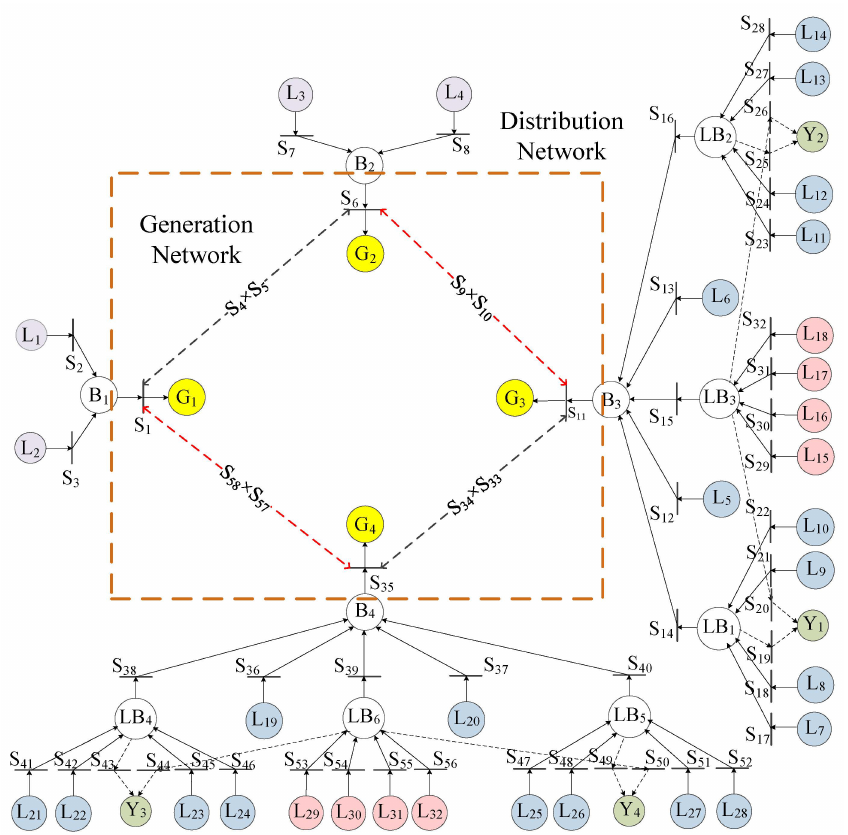
Figure 4. Petri net model for the floating nuclear power plant